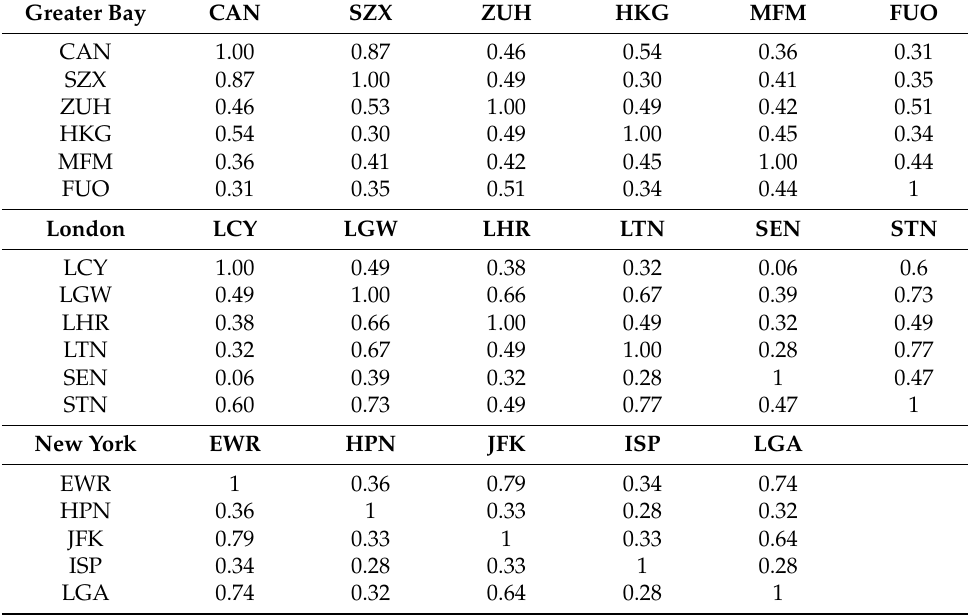
Table A6. Homogenization result of the third